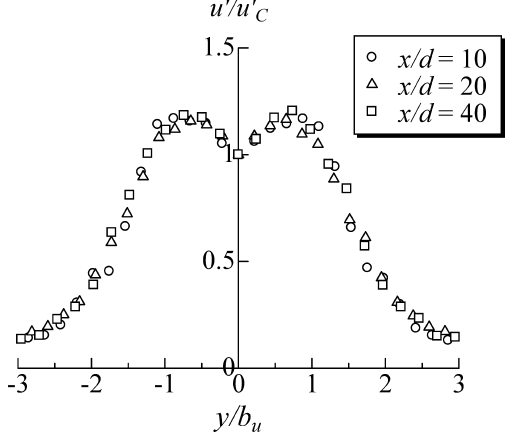
Fig. 3 Cross-streamwise profiles of r.m.s. value of velocity